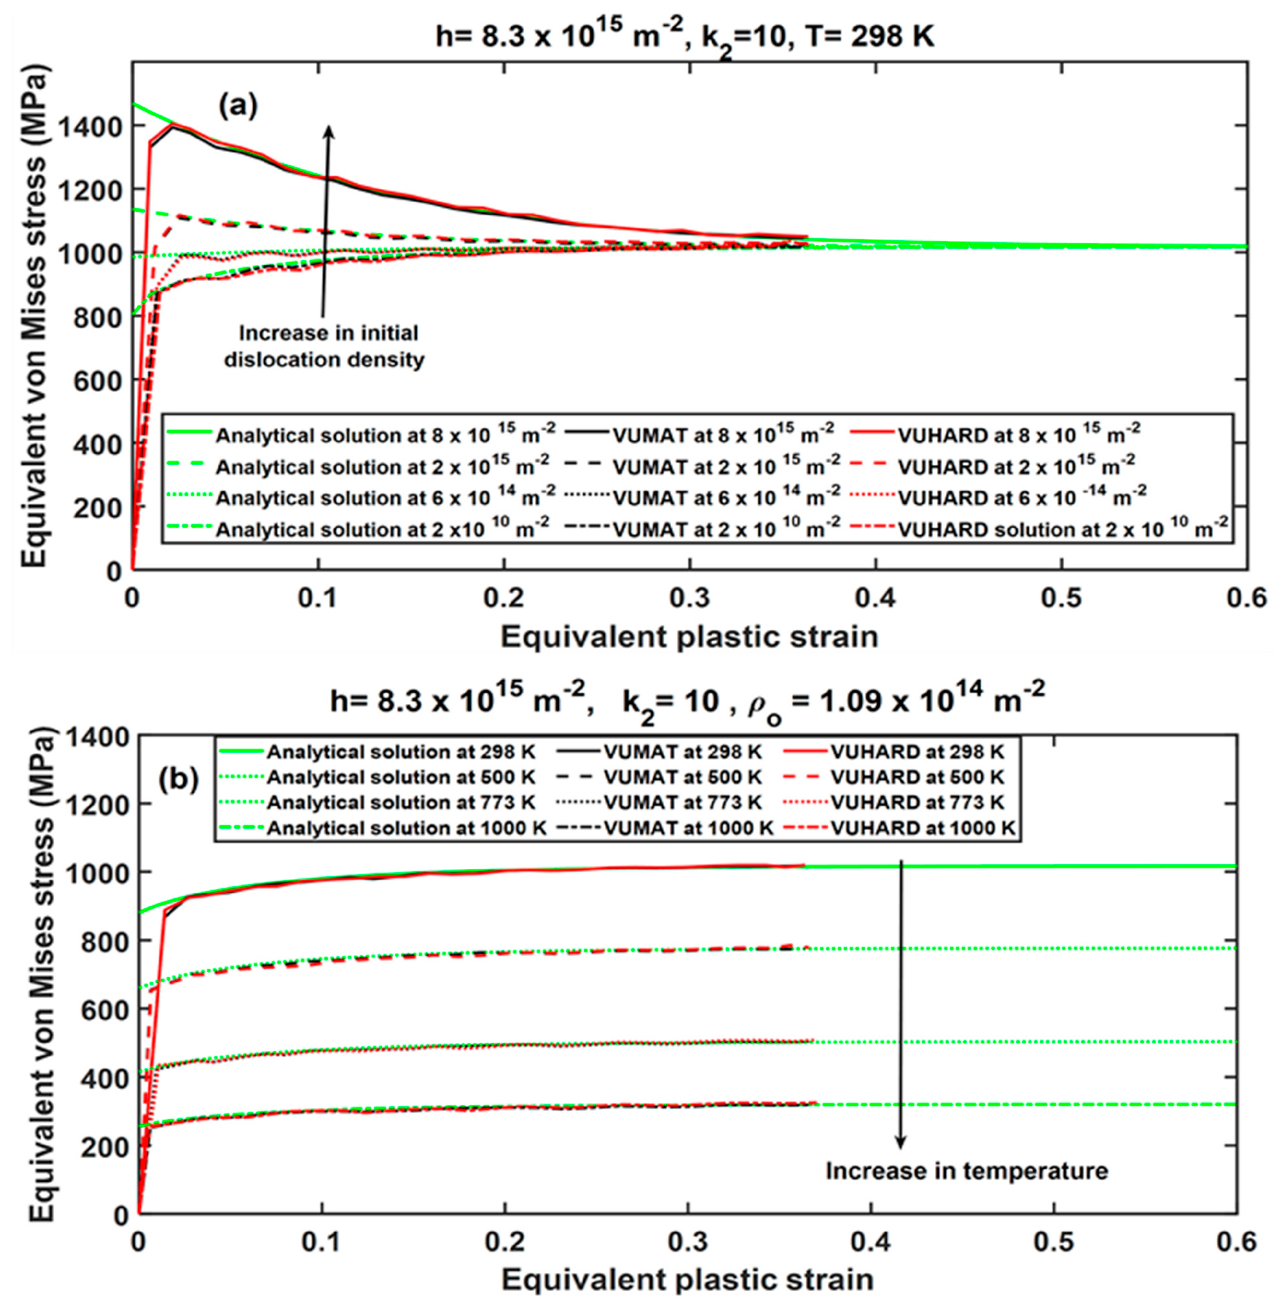
Figure 8. The effects of ( a ) initial dislocation density ( ρ o ) and ( b ) temperature on the numerical solutions derived from VUMAT and VUHARD subroutines, compared with the analytical solutions at the same average strain rate of 350 s − 1 .